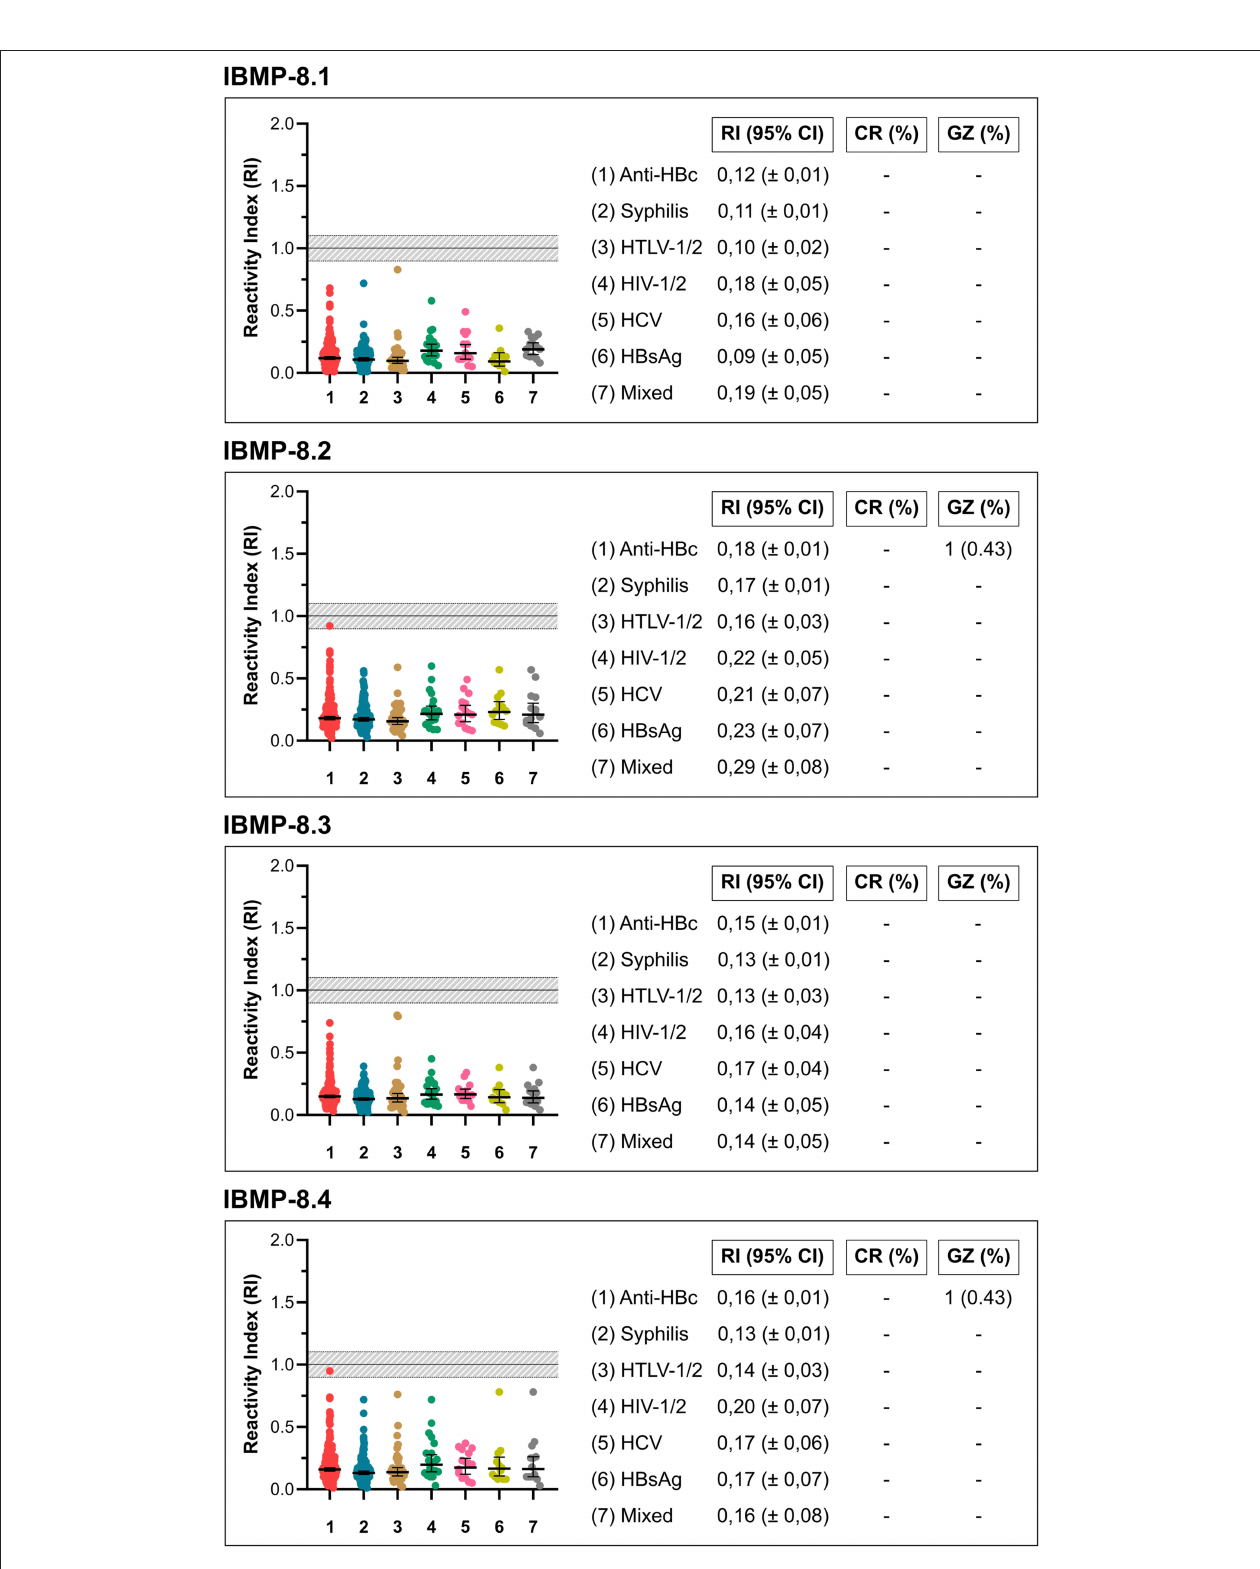
FIGURE 4 | Graphical analysis of cross-reactivity with IBMP antigens using non-negative samples screened by HEMOBA Foundation. 95% CI, 95% confidence interval; IR, reactivity index.